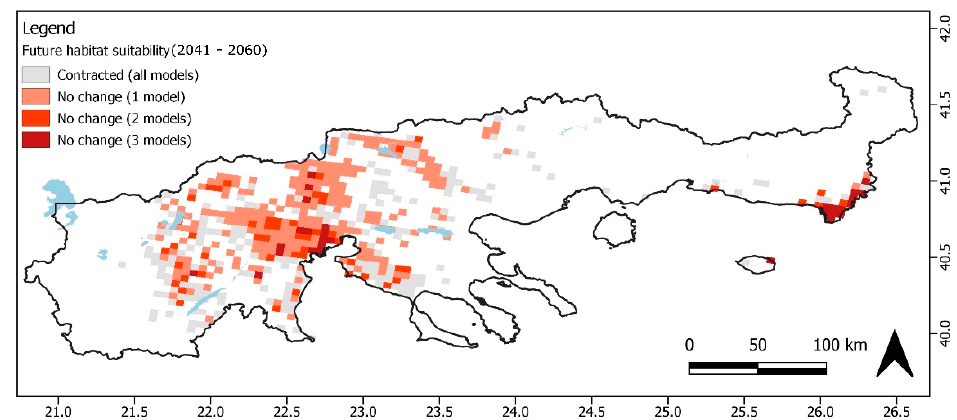
Figure 3. Near-future (2041 − 2060) Spermophilus citellus predicted habitat suitability contraction (grey) and persistence (light to dark red) under three future scenarios (SSP/RCP 2 − 4.5, 3 − 7.0, 5 − 8.5; mean suitability of BCC-CSM2-MR2, CNRM-CM6-1, CanESM5 global climate models ≥ 0.6). Dark red grid cells denote areas predicted to remain suitable for the species under all future scenarios and can therefore be considered most likely to be climate refugia. Map resolution: 4.5 km.